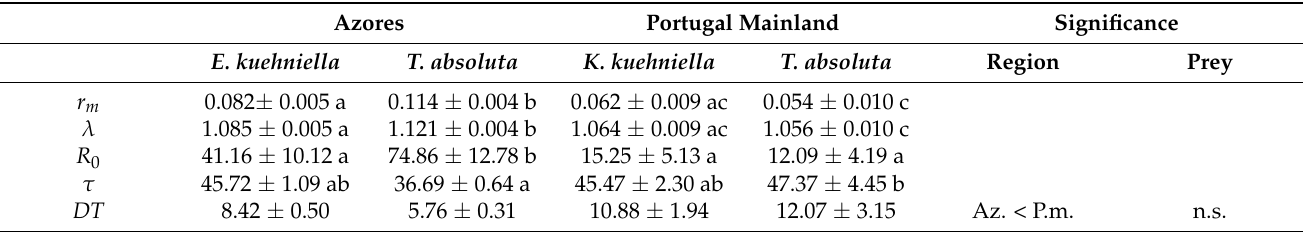
Table 4. Population growth parameters of Macrolophus pygmaeus from the Azorean and Portugal mainland populations fed on single diets Tuta absoluta or Ephestia kuehniella eggs (25 ± 1 ◦ C; 75 ± 5% relative humidity and light regime